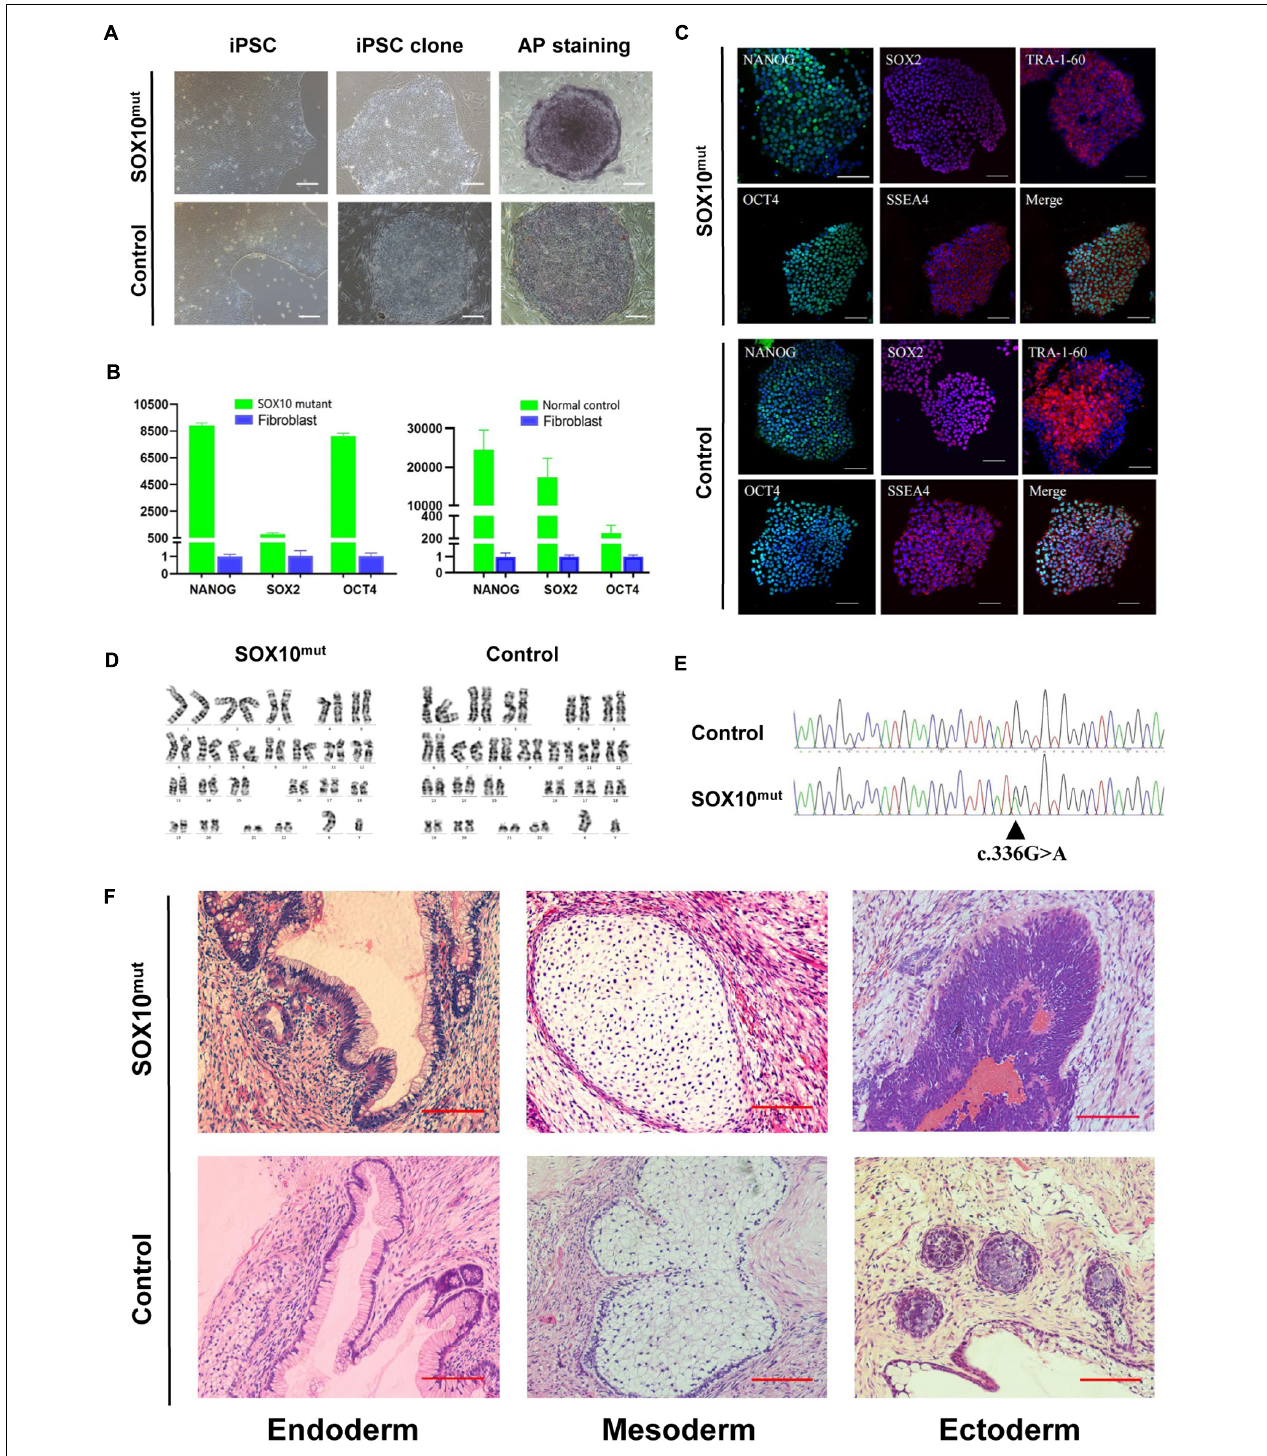
FIGURE 3 | Induction and characterization of SOX10 mutant and normal control iPSCs. (A) The SOX10 mutant and normal control iPSC clones with typical embryonic stem cell-like and positive alkaline phosphatase staining. Bar, 100 µ M. (B) qPCR analysis of pluripotency markers in both iPSC lines showed significantly upregulated expression of OCT4, SOX2 and NANOG, in contrast to fibroblasts. (C) Immunofluorescence staining in both iPSC lines showed expression of pluripotency markers OCT4, NANOG, TRA-1-60, SOX2, and SSEA-4. Bar, 100 µ M. (D) Karyotyping analysis showed normal chromosomal structure and numbers in both iPSC lines. (E) Sanger sequencing confirmed the mutation in SOX10 in iPSC lines. (F) H&E stainings of teratomas generated from subcutaneous injection of both iPSC lines in NOD/SCID mice. Tumor sections represent differentiated structures as noted. Bar, 100 µ M.